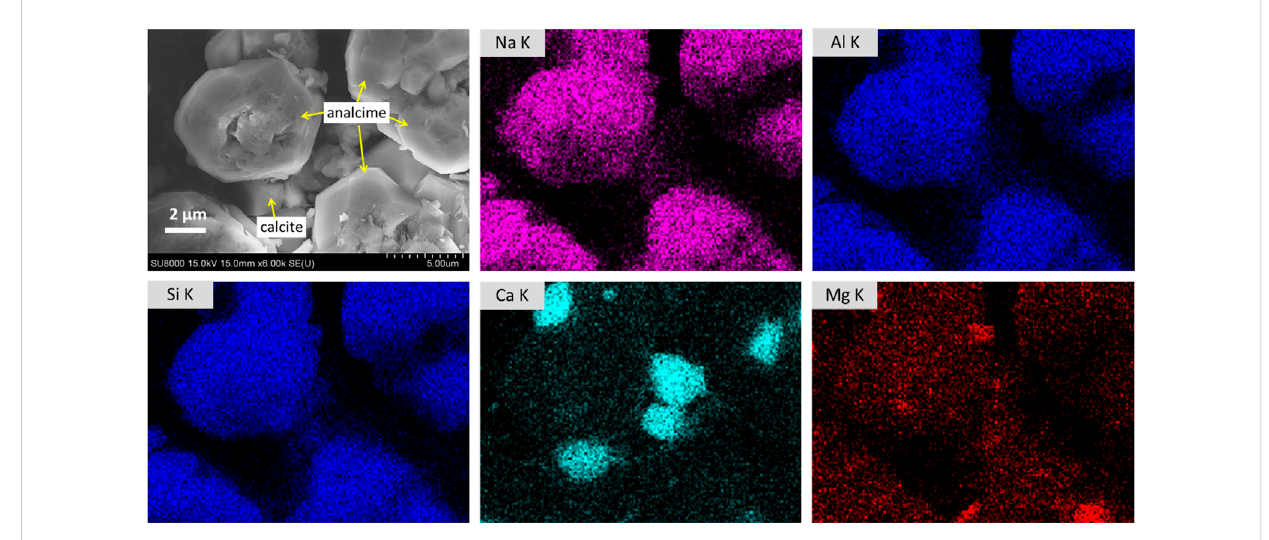
FIGURE 8 SEM images and EDS measurement of analcime and calcite in solid samples collected after reacting basalt in NaHCO 3 solution at 300 ° C for 5 days (Run 4). Deltoidal icositetrahedrons with the main chemical composition of Na, Al, and Si were considered as analcime whereas small Ca-rich particles between analcime were considered as